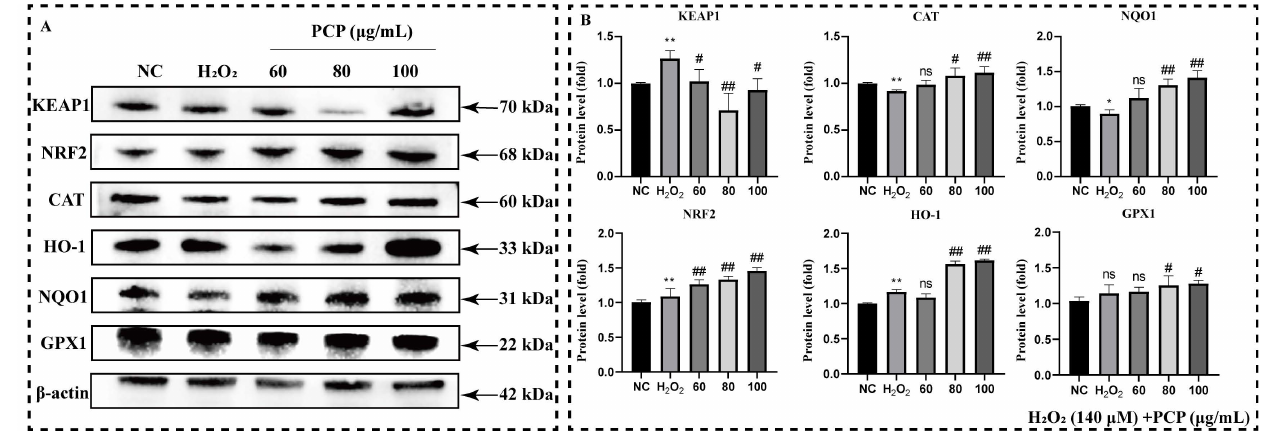
Figure 6. PCP upregulates NRF2/HO-1 antioxidant pathway in microglia. The cells were treated with H 2 O 2 (140 µ mol) and PCP at varying concentrations (0, 60, 80, and 100 µ g/mL) for 24 h. The NC group that set and treated with DMEM as the control. Then, we measured the levels of KEAP1, NRF2, CAT, HO-1, NQO1, and GPX1 proteins using Western blotting and estimated the grey value by ImageJ. KEAP1, NRF2, CAT, HO-1, NQO1, and GPX1 proteins ( A ); Statistics of a protein’s grey value after β -actin standardization. ( B ). ( ns p > 0.05, * p < 0.05, ** p < 0.01, # p < 0.05, and ## p <